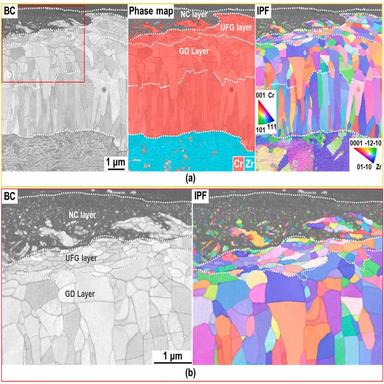
(a) Cross-sectional TKD images of worn area on Cr-coated cladding tested under 20 Hz; (b) magnified area of the NC layer, UFG layer, and GD layer.